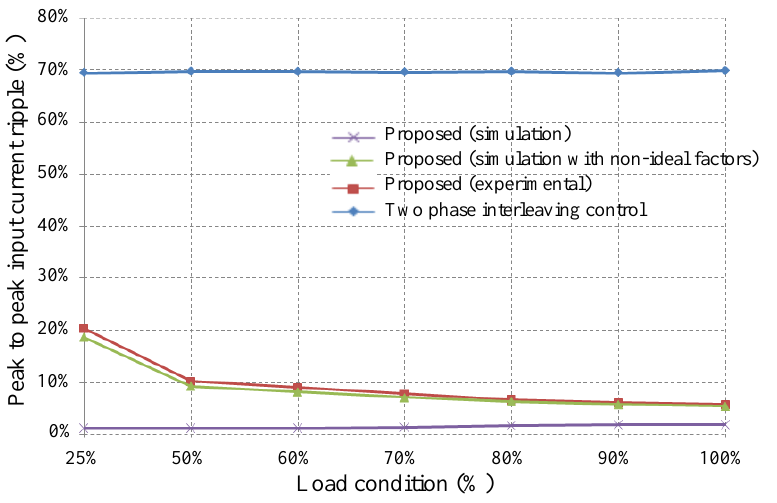
Figure 15. Peak to peak input current ripple under different loads.